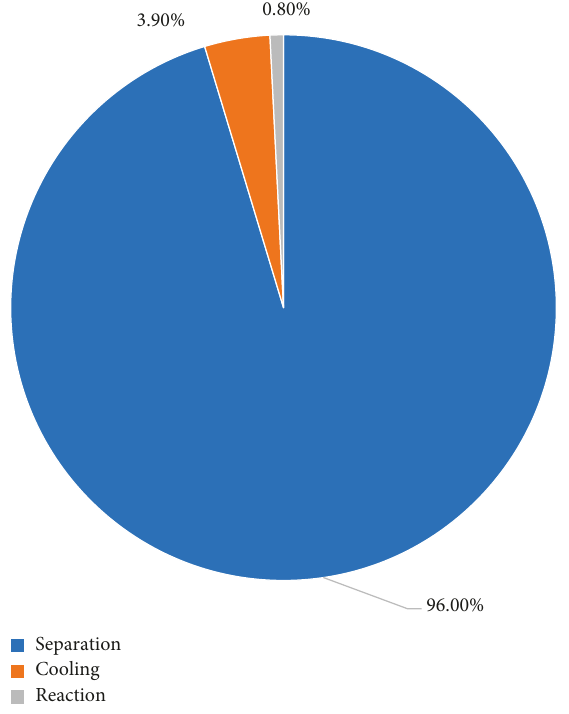
Figure 9: Contribution of unit operations to the irreversibilities of the polyfunctional reaction stage.